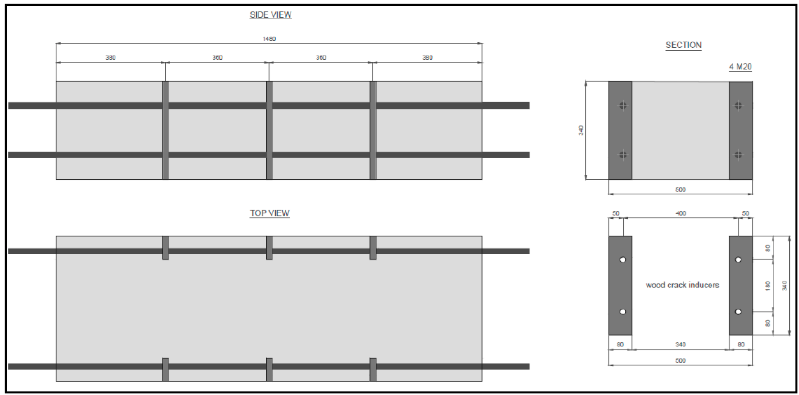
Figure 4. Transverse and longitudinal sections for concrete specimens. Table 2. Mixed components .